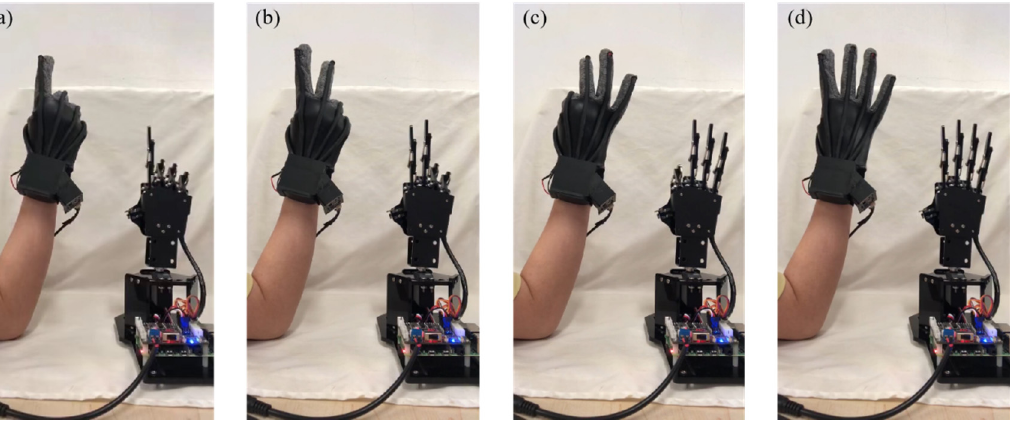
Figure 8. Video screenshots of linkage between data glove and manipulator. The manipulator tracks the hand gestures of the data glove in real-time. ( a ) Number 1. ( b ) Number 2. ( c ) Number 3. ( d ) Number 4.